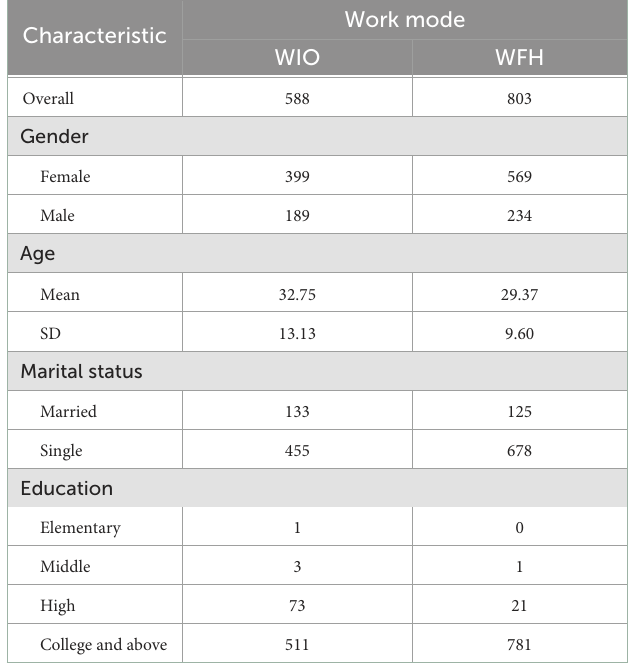
TABLE 2 Demographic characteristics of 1,391